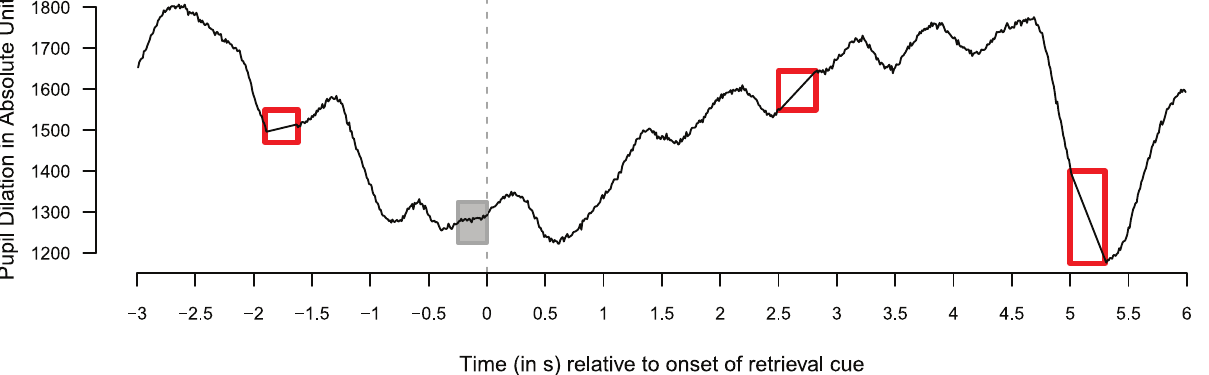
Figure 2. Typical raw pupillary response measured during a first test-trial. Red boxes indicate regions where the pupillary response was linearly interpolated; grey box indicates baseline used to calculate relative pupil dilation (see Figure